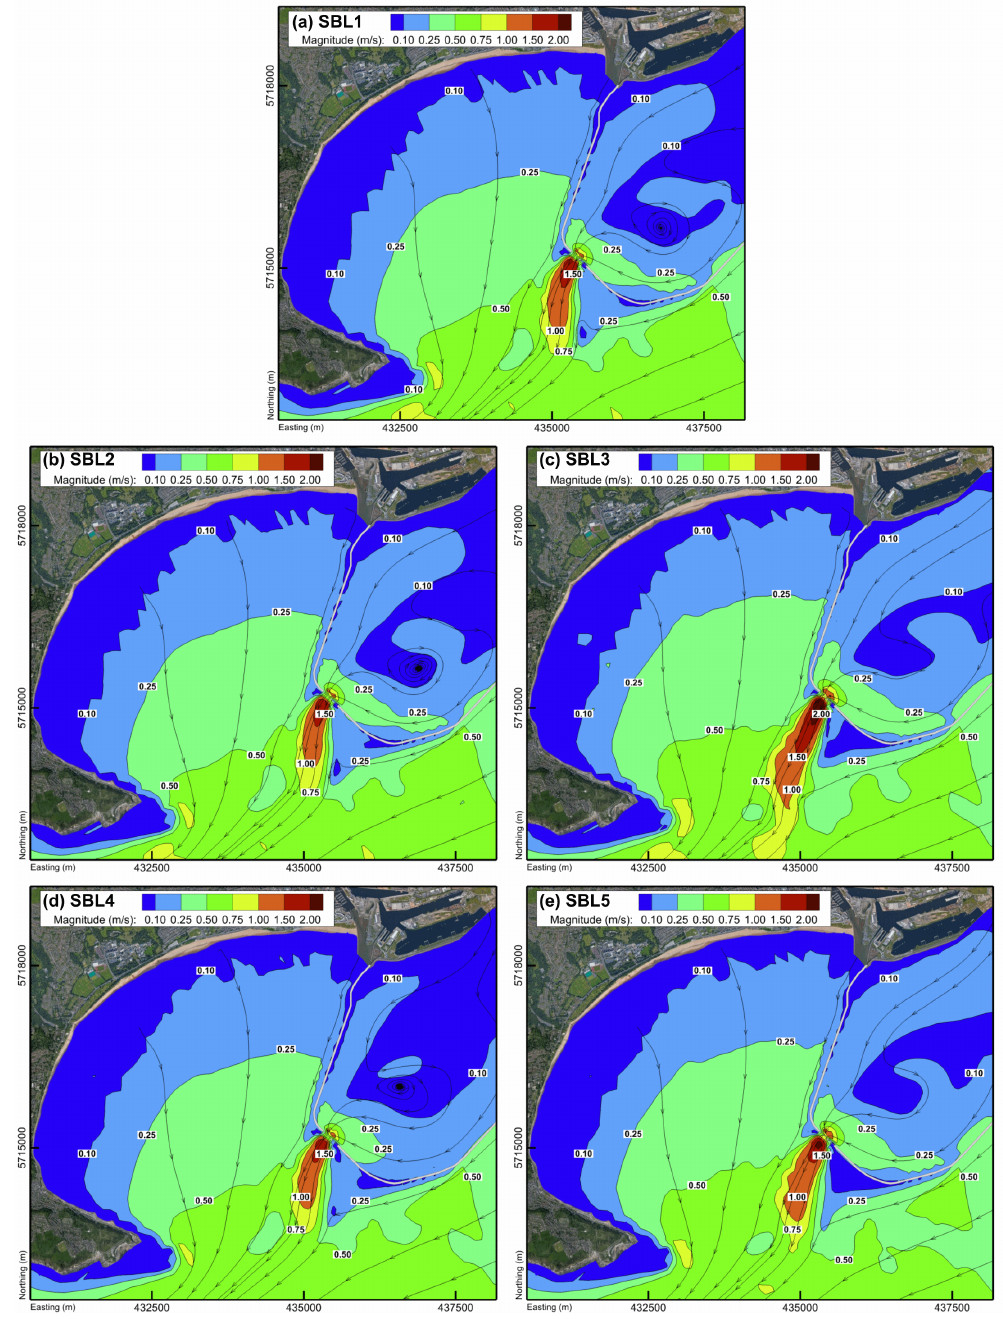
Figure 13. A comparison of velocity fields during the ebb generation phase for a typical spring tidal cycle. ( a ) 2D simulation with no refinements (SBL1); ( b ) 2D with A T 1 = 216.1 m 2 (SBL2); ( c ) 2D with A T 2 = 38.5 m 2 (SBL3); ( d ) 3D with A T 1 = 216.1 m 2 (SBL4); ( e ) 2D with A T 2 = 38.5 m 2